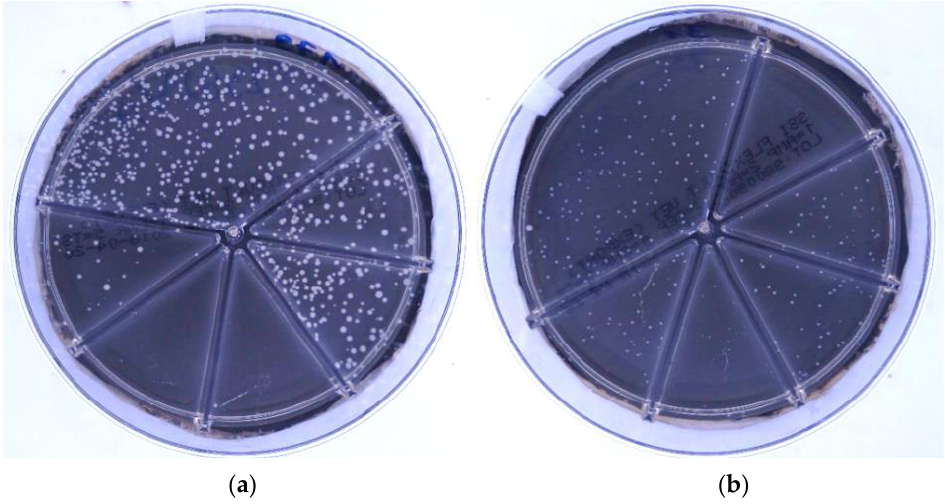
Figure 3. Pale-looking bacteria of ( a ) Staphylococcus pseudintermedius and ( b ) Enterococcus faecium on